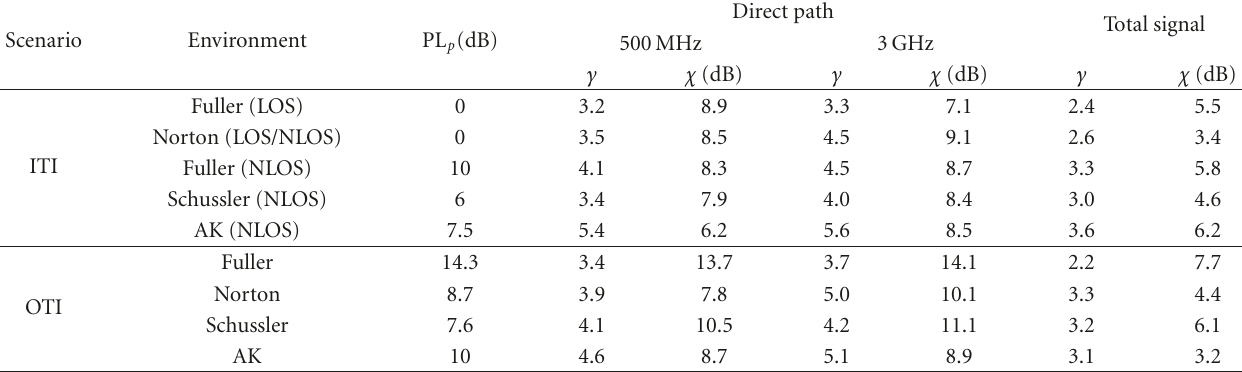
Table 1: UWB pathloss modeling